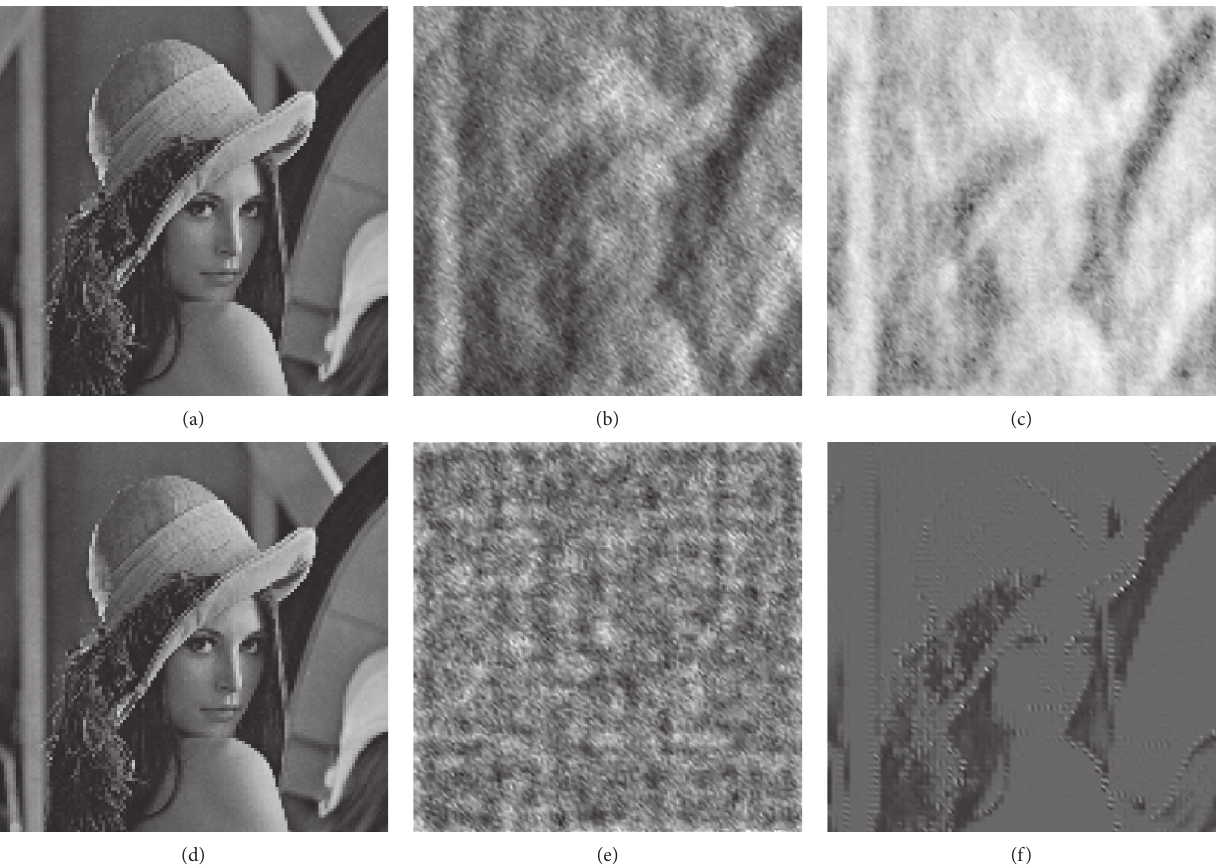
Figure 10: The reconstructed image based different sparse transformation. (a) The original image of Lena. (b–f) The reconstructed image based on DCT, DFT, and KSVD sparse representation, respectively, and QR-CGI-OE AND XOR-LWT-OE algorithms.